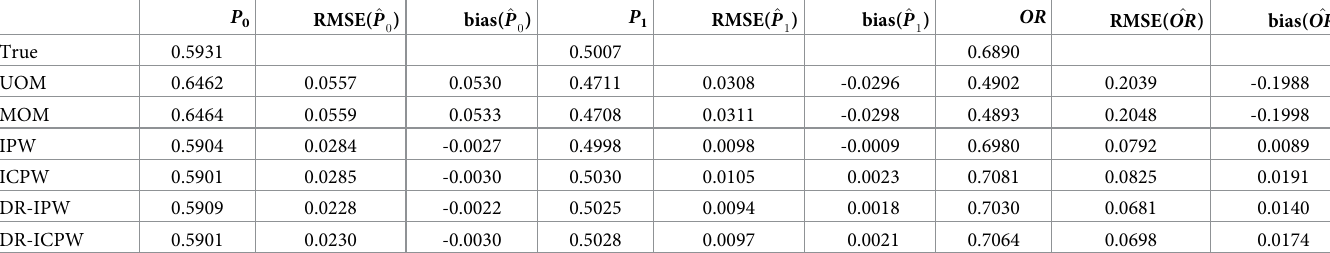
Table 5. Result of scenario 1, a simulation setting that mimics the realistic data, i.e. Subset-BRD dataset.